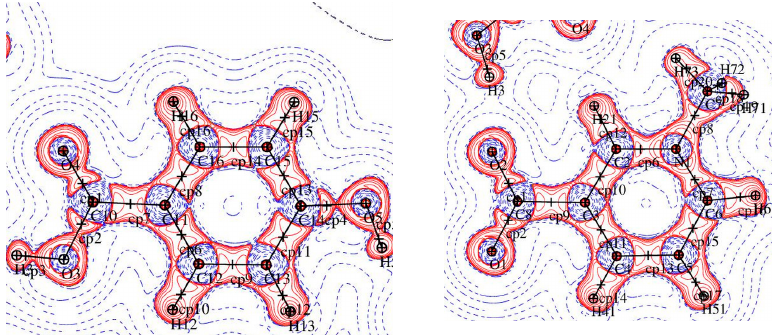
Figure 3. A plot of the Laplacian of the electron density in two parts of 1 : ( left ) p-hydroxybenzoic acid and ( right ) pyridine ring.